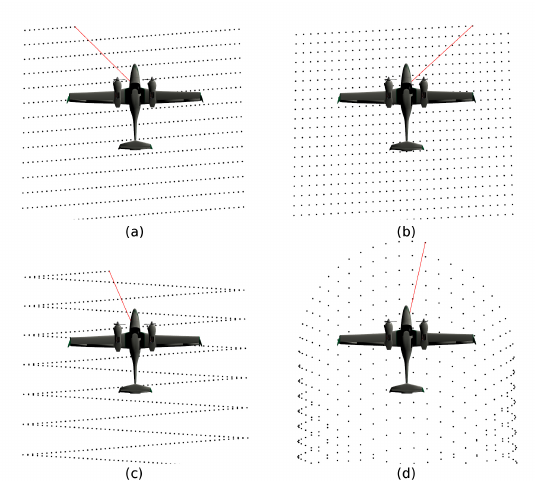
Figure 1: Different scan patterns supported by HELIOS: (a) rotat- ing mirror, (b) fiber array, (c) oscillating mirror, (d) conic mirror. Aircraft 3D model: CC-BY-SA Emmanuel Baranger and thus, indirectly, the number of subsampling rays and their density.